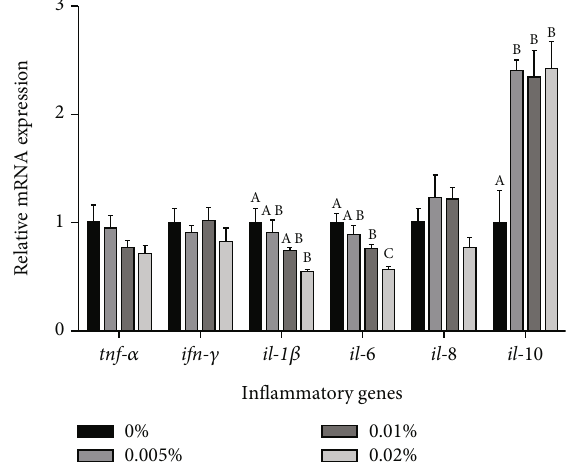
Figure 4: Expression of genes related to in fl ammation in visceral mass of large yellow croaker larvae. Tnf-a: tumor necrosis factor a; ifn- γ : interferon γ ; il-1 β : interleukin-1 β ; il-6 : interleukin-6; il-8 : interleukin-8; il-10 : interleukin-10. Values are means ( n = 3 ), with their standard errors represented by vertical bars. Bars bearing the same or no letters were not signi fi cantly di ff erent determined by Tukey ’ s test ( P > 0 : 05